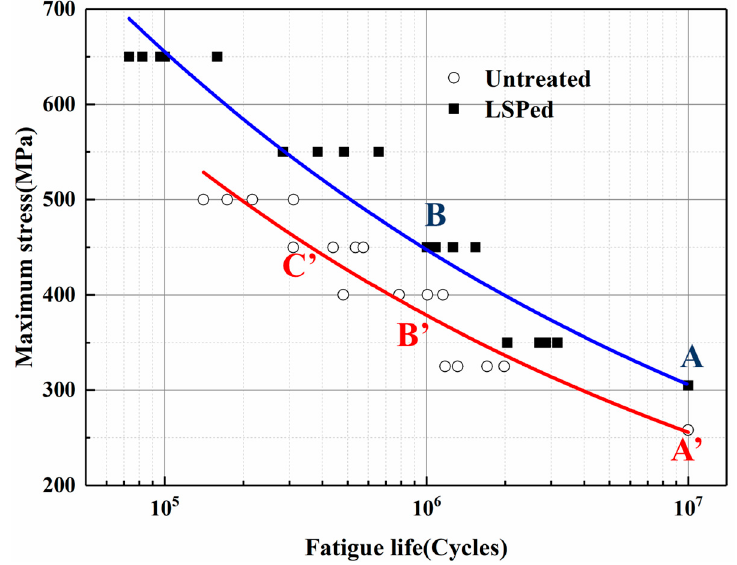
Figure 5. S–N fatigue life curves before and after LSP(R = 0.1).